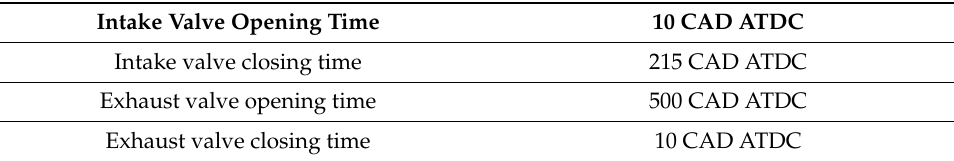
Table 2. Experimental engine characteristics.